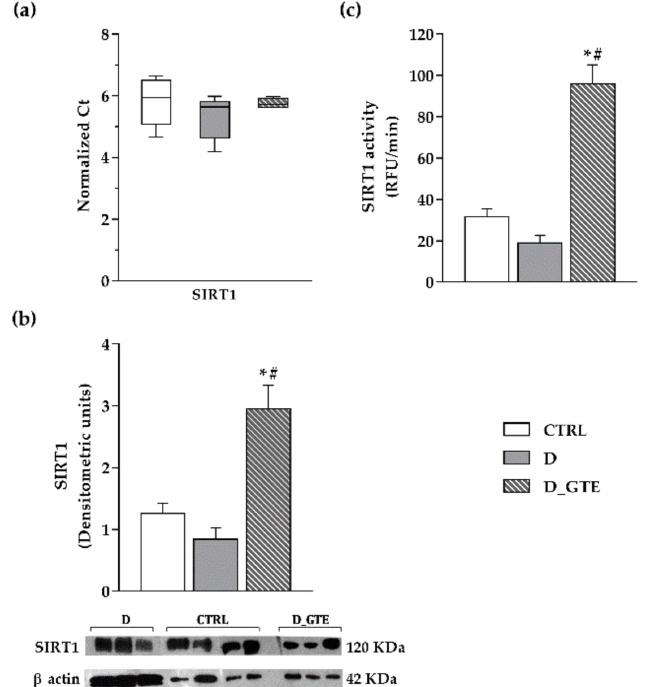
Figure 6. SIRT1 mRNA and protein expression levels and activity. ( a ) Box plot distribution of normalized CTRL, D and D_GTE Ct values of SIRT1. The Ct value of the reference gene was normalized over the Ct value of GAPDH. Higher normalized Ct values correspond to lower gene expression levels; ( b ) Typical electrophoretic separation and immunodetection of SIRT1 in the heart tissue of CTRL, D and D_GTE rats. The expression levels (densitometric units) of SIRT1 were measured by densitometric analysis and normalized to β -actin. ( c ) SIRT1 activity determined in CTRL, D and D_GTE rat heart tissue. The activity was reported as relative fluorescence units (RFU)/min. Histograms show the mean ± SEM. * p < 0.05 significant differences vs. CTRL; # p <